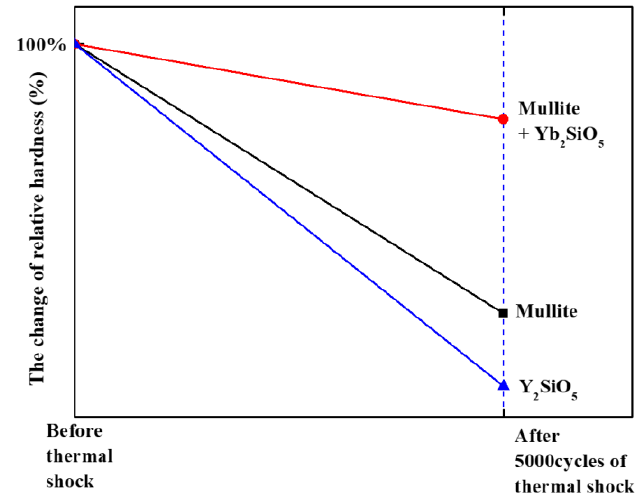
Figure 11. Hardness changes of EBC materials during thermal shock tests.